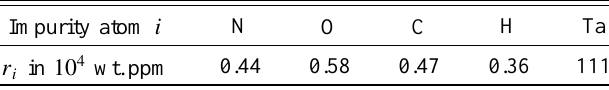
TABLE I. Resistivity coefficients of common impurities in Nb